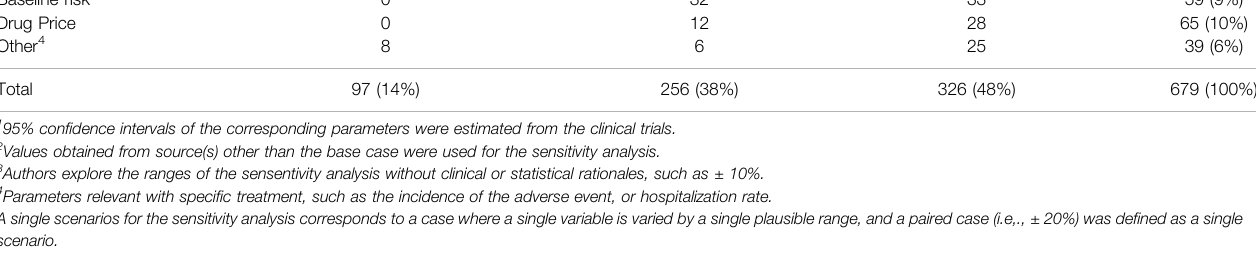
Frontiers in Pharmacology |